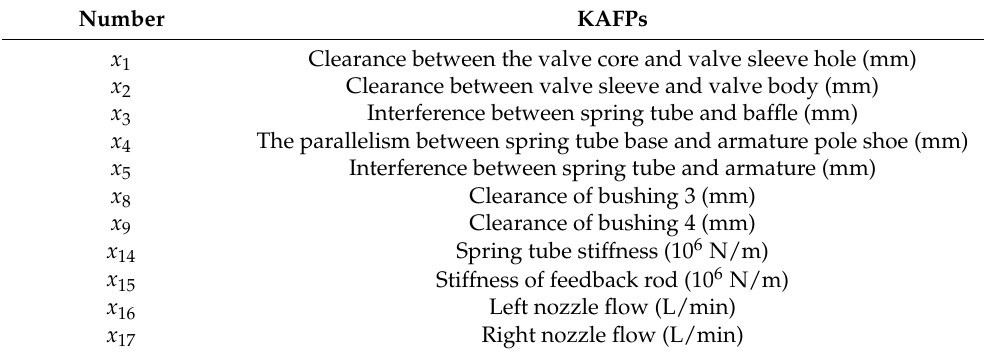
Table 4. The KAFPs selection results.